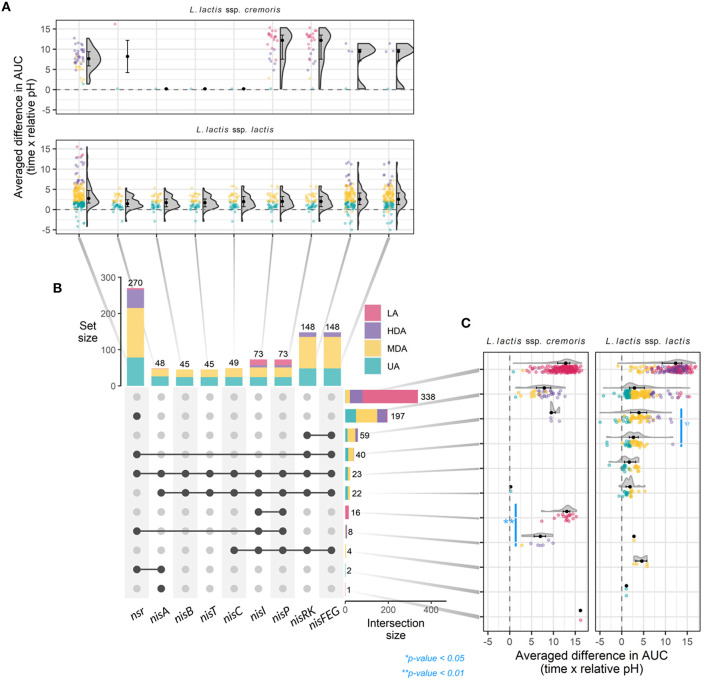
Gene-trait matching of nisin tolerance genotypes with milk acidification patterns. (A) Raincloud plots depicting the averaged ΔAUC of every strain for milk acidification curves with and without nisin, grouped by individual nisin-related gene and subspecies. (B) Matrix layout showing individual presence (vertical) and overlap in (horizontal) nisin-related genes in 710 L. lactis strain and the respective distributions of phenotypes and total number of strains that contain the indicated gene or set of genes. Dark dots connected with solid lines indicate genes present in a group, while gray dots indicate gene absence. (C) Raincloud plots depicting ΔAUC values as in (A), but now grouped by genotype for nisin-related genes and subspecies. For all raincloud plots, black dots represent the median values whereas black lines mark the boundaries for the center 50% of the distribution. P-values were calculated using the Mann-Whitney-Wilcoxon test.